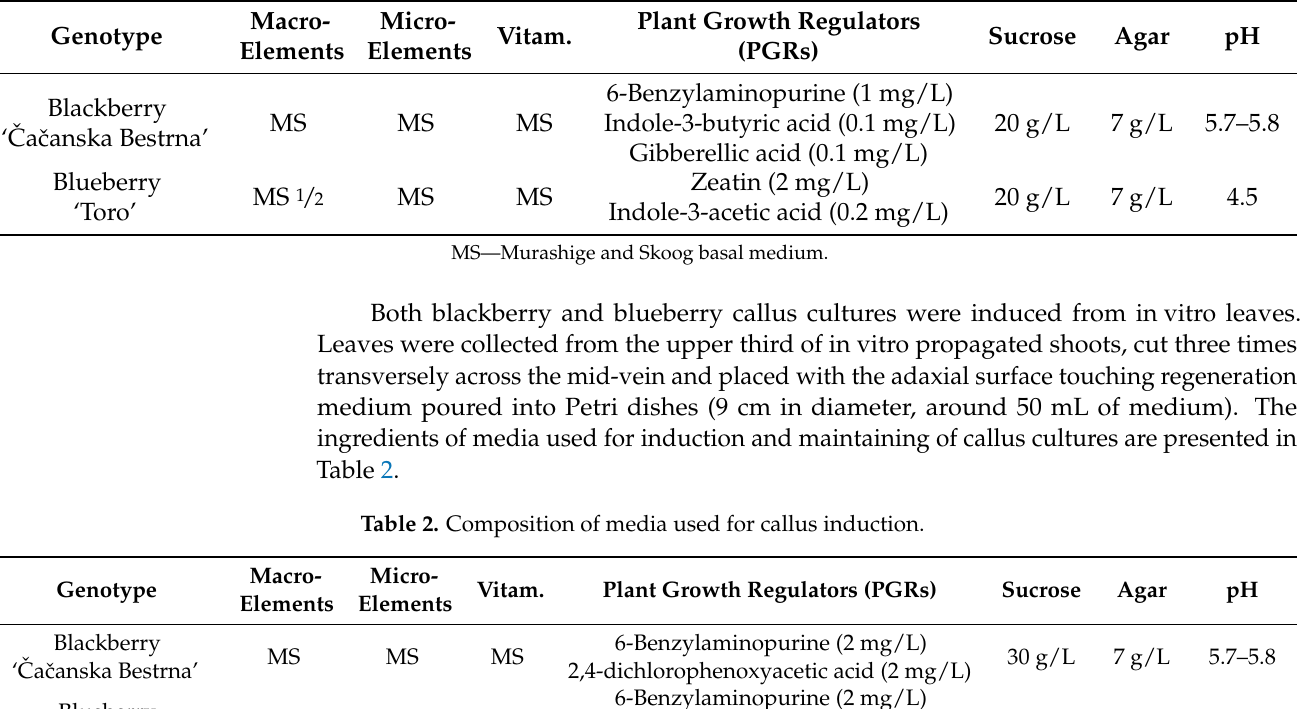
Table 1. Composition of media used for micropropagation of blackberry and blueberry.